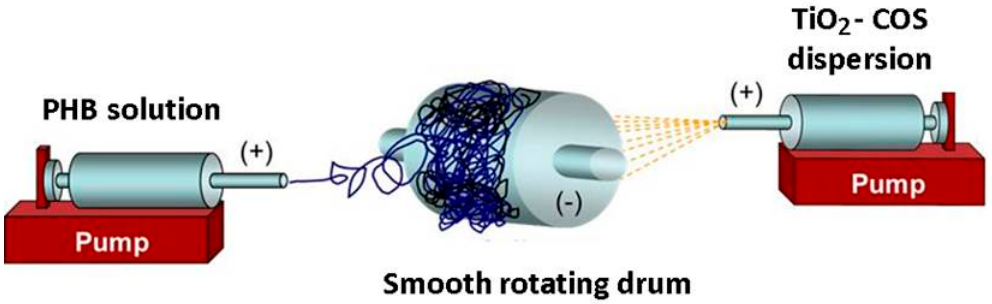
Figure 1. Schematic diagram of the electrospinning/electrospraying setup.